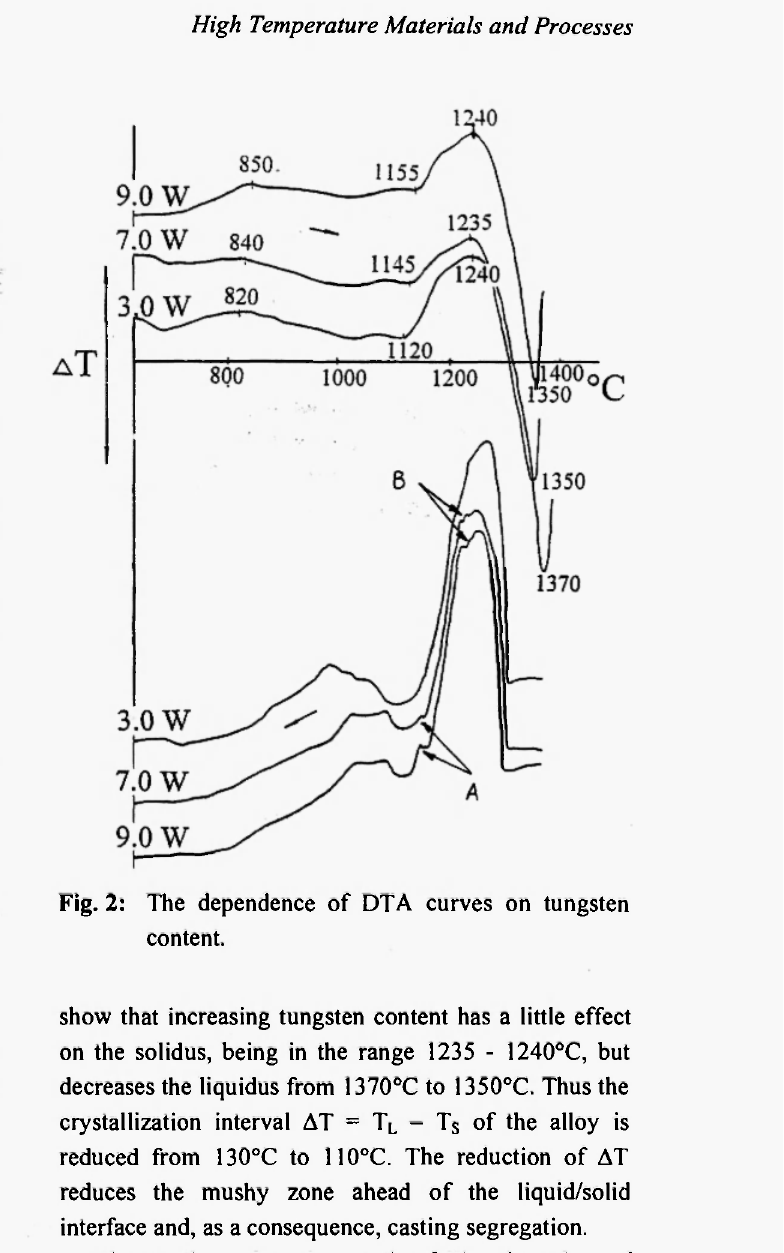
Fig. 2: The dependence of DTA curves on tungsten